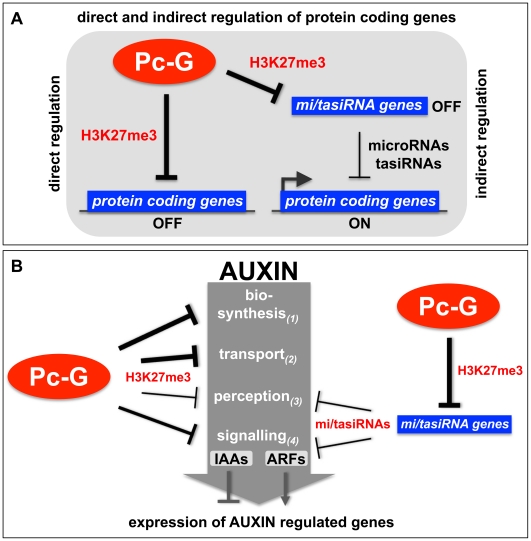
Models of the H3K27me3-mediated regulation of protein coding genes and auxin signaling.(A) Protein coding genes can be directly repressed by Pc-G proteins through the deposition of H3K27me3 or indirectly positively regulated by Pc-G proteins through the H3K27me3-mediated repression of small RNA genes (tasiRNAs and miRNAs) (see Table 1, Table 2 for details). (B) Pc-G proteins directly repress auxin biosynthesis, transport, perception and signaling (IAA transcription factors). Thickness of arrows is relative to number of genes targeted by H3K27me3. Pc-G proteins indirectly activate genes involved in auxin perception and signaling (ARF transcription factors) through the repression of miRNA (mir160, 167, 393) and tasiRNA (TAS3) genes. Positive regulation of the ARF transcriptional activator and auxin perception genes and negative regulation of IAA transcriptional repressor genes likely promotes expression of auxin inducible genes (see Table 3, Table 4 for details).